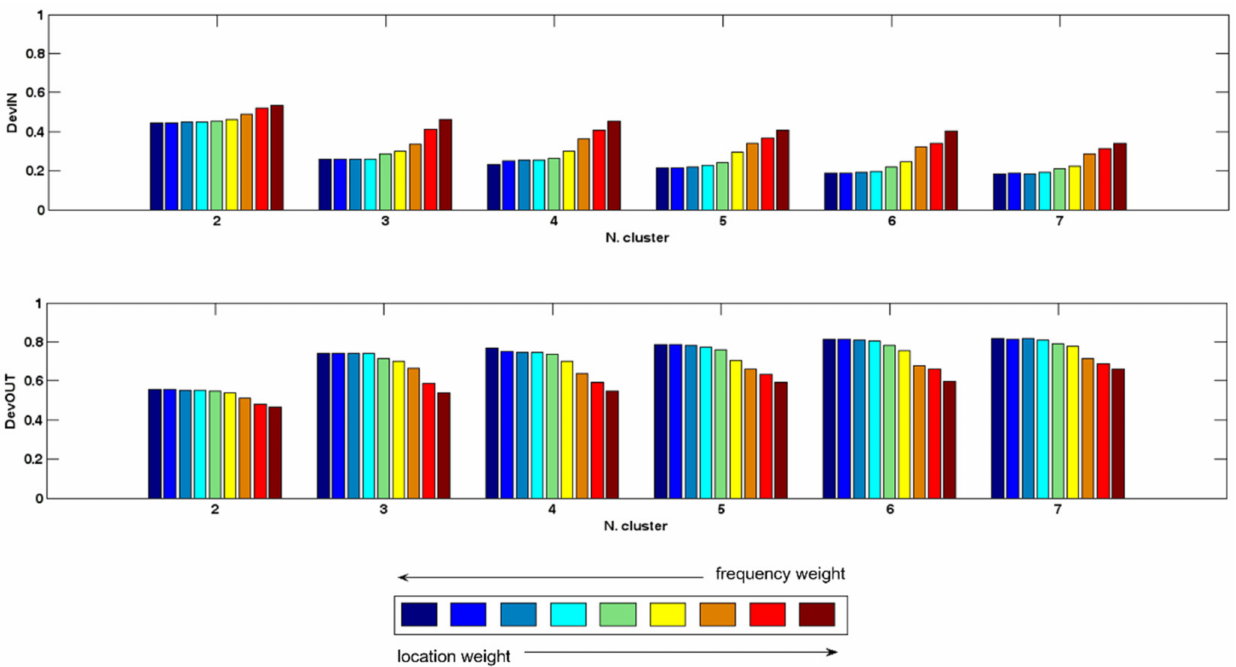
Figure 1. Histograms showing the trend of DEVI N ( top ) and DEV OUT ( bottom ) for the number of clusters k ranging from 2 to 7 clusters, as the weight set varies from #1 to #9 (from deep blue to brown).